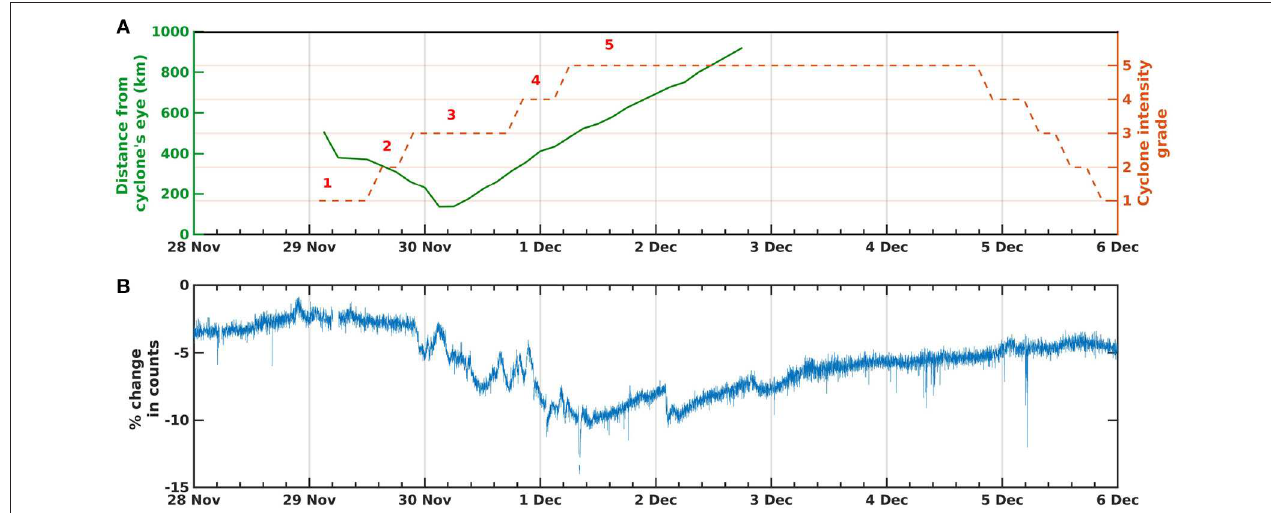
FIGURE 5 | (A) Solid curve shows the distance of the observation site from the eye of the Cyclone Ockhi, and dashed line shows the intensity of the cyclone represented by various stages. Here, stages 1, 2, 3, 4, and 5 indicate depression, deep depression, cyclonic storm, severe cyclonic storm, and very severe cyclonic storm, respectively. (B) Total γ -ray counts detected by NaI at